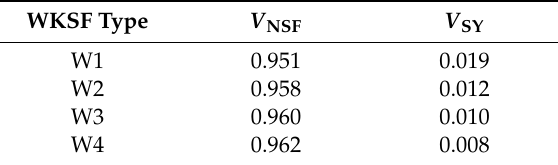
Table 2. V NSF and V SY